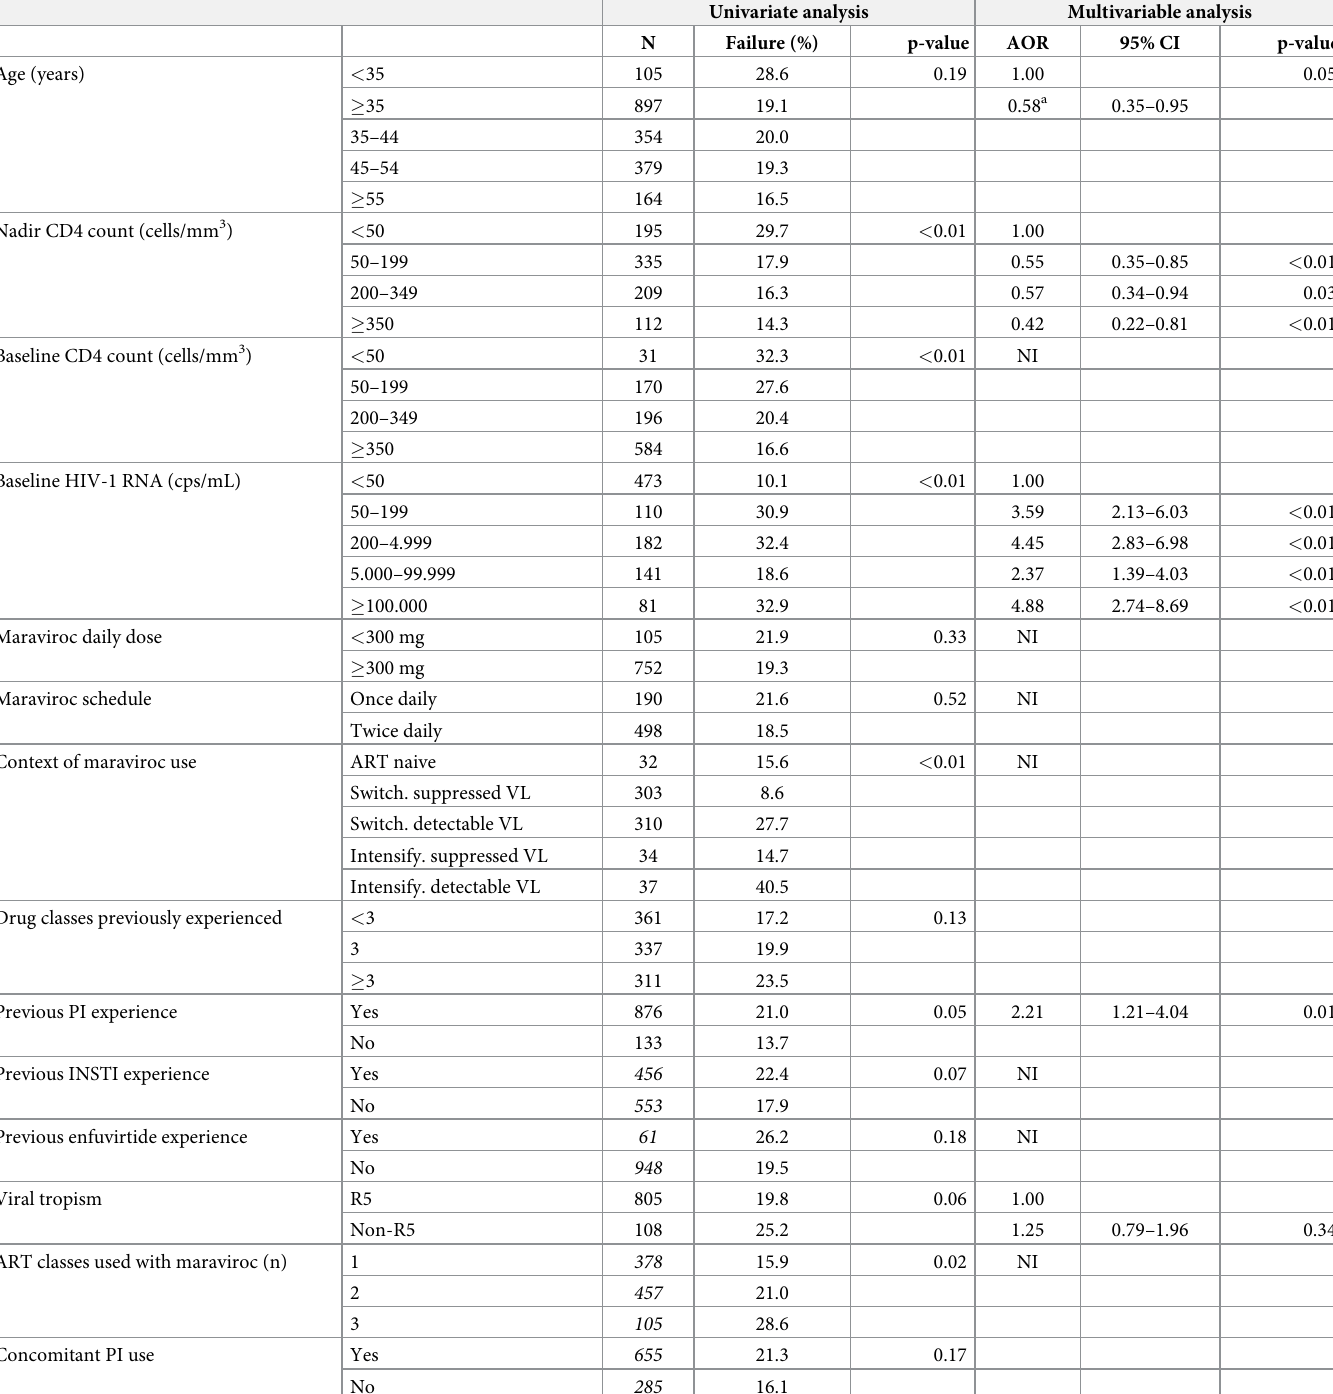
Table 5. Univariate and multivariable logistic regression analysis of factors associated with virological failure at 48 weeks.